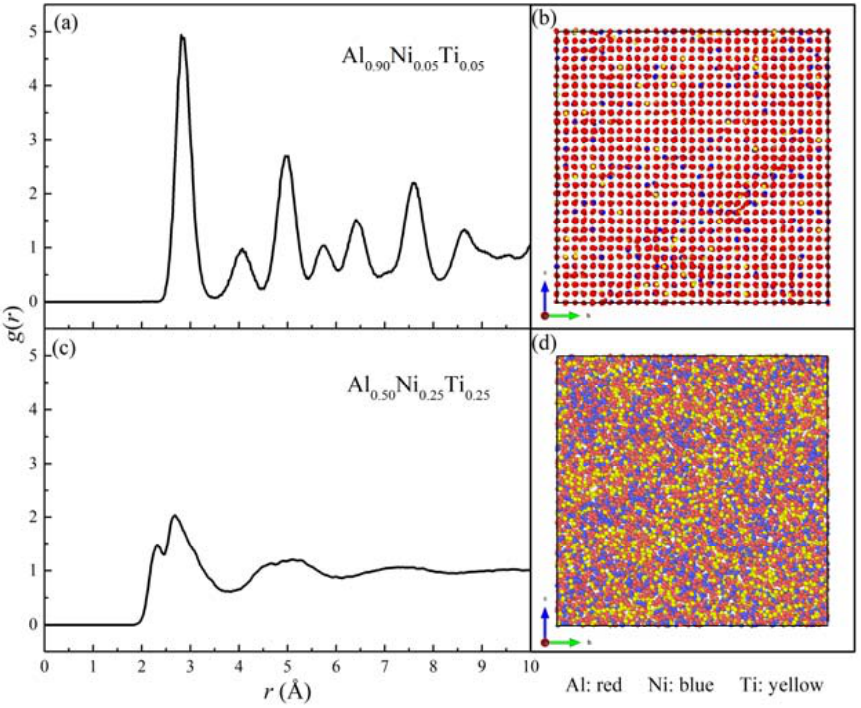
Figure 2. Total pair correlation functions ( g (r)) and projections of atom positions for ( a , b ) the crys- talline state (Al 0.90 Ni 0.05 Ti 0.05 ) and ( c , d ) the amorphous state (Al 0.50 Ni 0.25 Ti 0.25 ) obtained by MD simulations at 300 K. Red, blue and yellow filled circles stand indicated the positions of Al, Ni and Ti atoms, respectively.